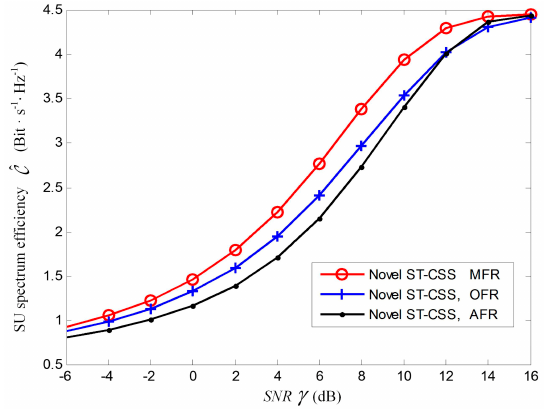
ˆ  Figure 8. SU spectral efficiency ˆ C versus SNR γ for the Novel ST-CSS scheme under hard decision Figure 8. SU spectral efficiency versus SNR  for the Novel ST-CSS scheme under hard fusion rules of OFR, MFR and AFR, decision fusion rules of OFR, MFR and AFR, respectively.